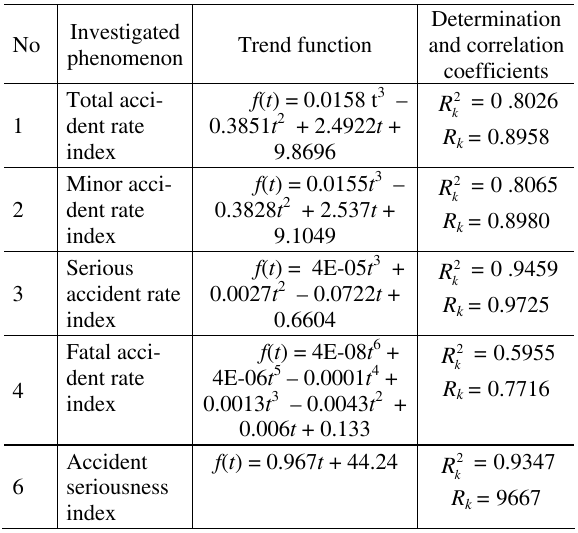
Table 2. Trend functions and determination and